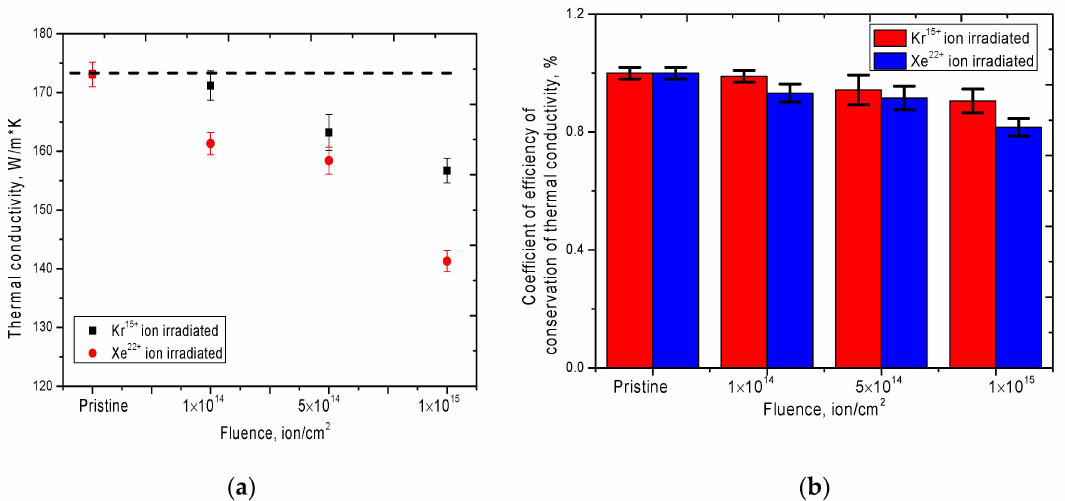
Figure 9. ( a ) Graph of the dependence of changes in the thermal conductivity of ceramics after irradiation; ( b ) Diagram of changes in the coe ffi cient of e ffi ciency of thermal conductivity conservation depending on the irradiation